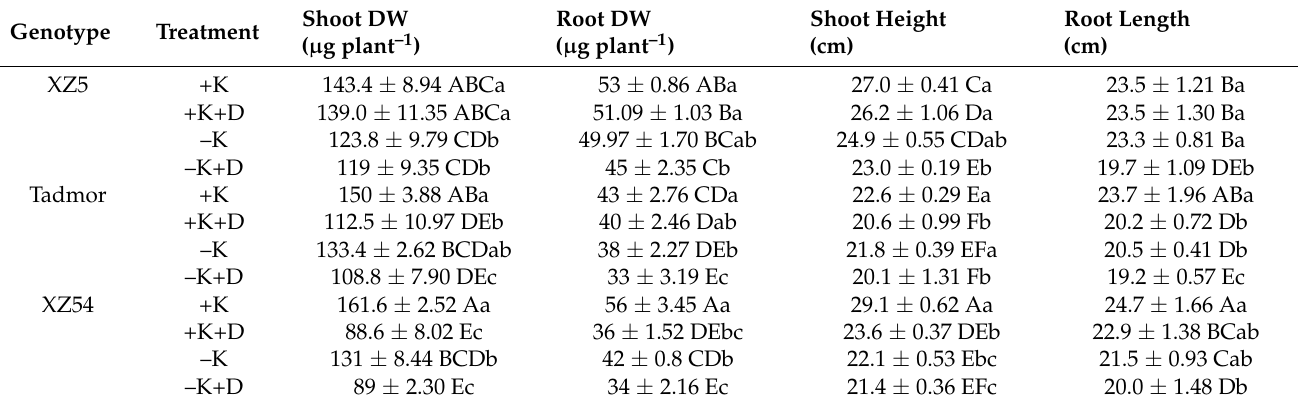
Table 1. Effect of K nutrition on biomass, shoot height and root length of three barley genotypes in response to drought stress. Shoot Genotype Treatment